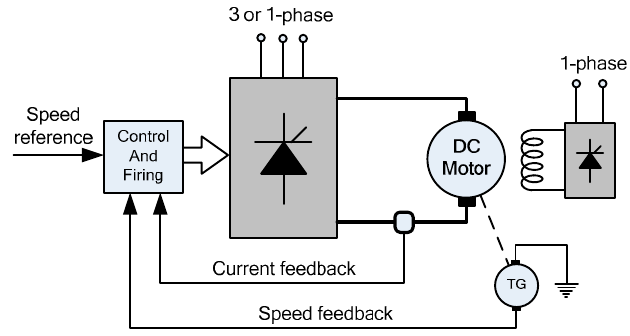
Figure 3. General closed-loop controlled rectifier-fed DC motor drive .